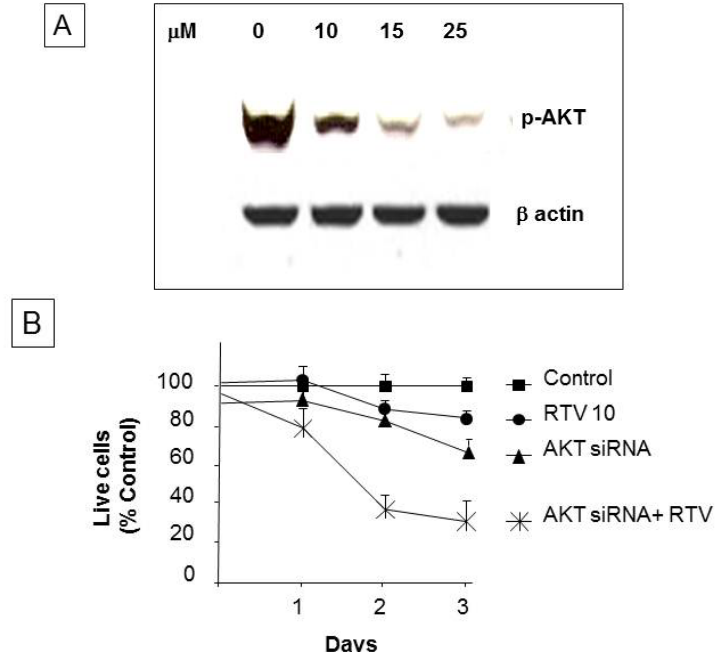
Figure 6. Western blot analysis for phospho-AKT and cell proliferation of AKT siRNA-treated PANC-1 cells: ( A ) 10 µg protein extracts of control and ritonavir-treated cells at the indicated concentrations were resolved by SDS-PAGE and probed with phospho-AKT antibodies. β actin was used as a loading control; ( B ) Growth inhibition by ritonavir and AKT siRNA. Cell growth is expressed as a percentage of control DMSO-treated cells and represents the mean of triplicate